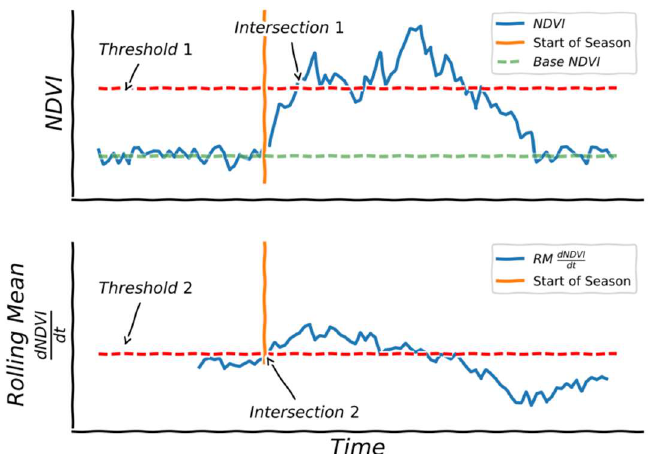
Figure 3. Schematic (non-real data) showing the approach used to calculate the start of the growing season. The two thresholds used to calculate the start of the season (horizontal dashed red lines), the intersection with the Normalized Difference Vegetation Index (NDVI) and rolling mean NDVI derivative (vertical sold orange lines), and the average 1 January to 16 March NDVI (base NDVI–horizontal dashed green line) values are illustrated.